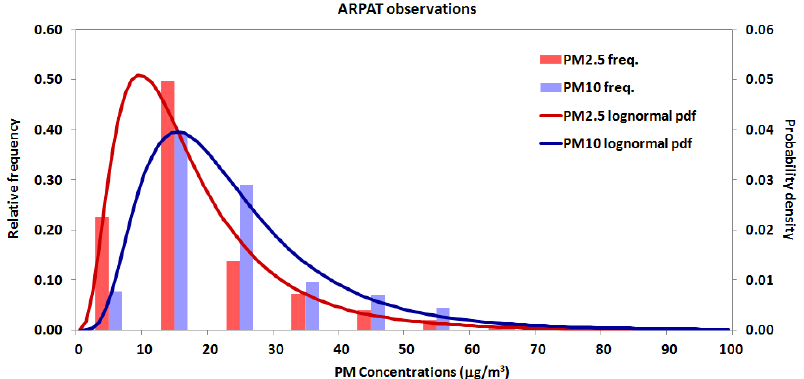
Figure 8. Frequency distribution and corresponding probability density function of PM 2.5 and PM 10 concentrations measured by the ARPAT reference station during field validation.